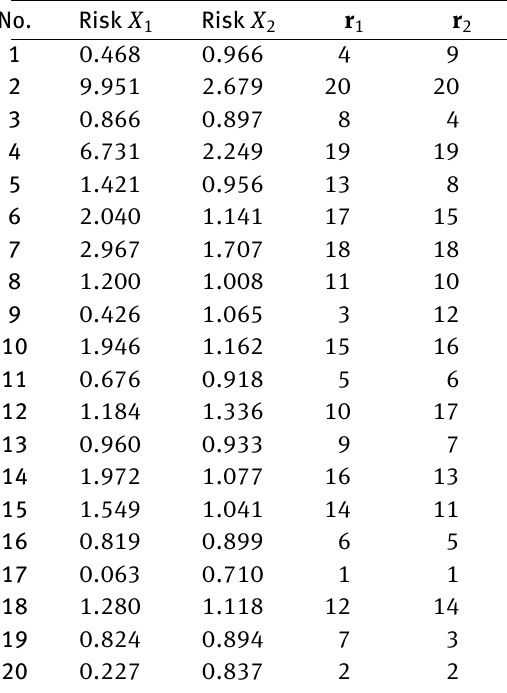
Table 1: The data from Cottin and Pfeifer [1]